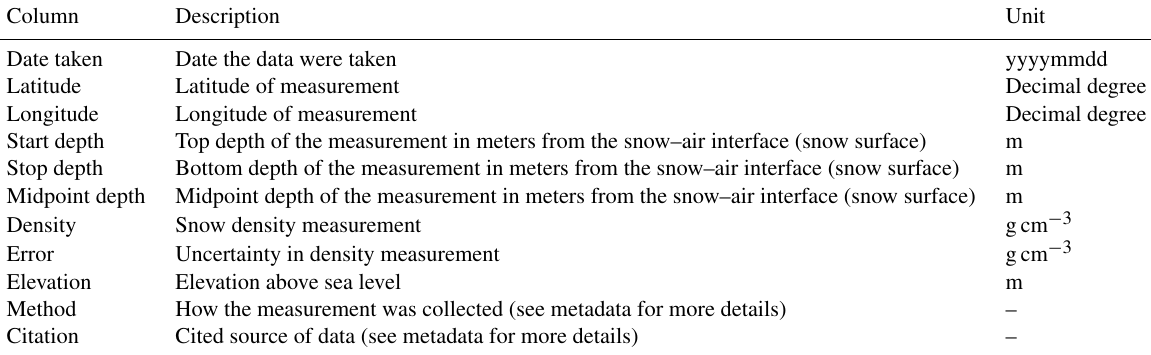
Table 1. The parameters for each snow density measurement in the SUMup dataset with a brief description and the unit of measurement. Column Description Unit Date taken Date the data were taken yyyymmdd Latitude Latitude of measurement Decimal degree Longitude Longitude of measurement Decimal degree Start depth Top depth of the measurement in meters from the snow–air interface (snow surface) m Stop depth Bottom depth of the measurement in meters from the snow–air interface (snow surface) m Midpoint depth Midpoint depth of the measurement in meters from the snow–air interface (snow surface) m Density Snow density measurement gcm − 3 Error Uncertainty in density measurement gcm − 3 Elevation Elevation above sea level m Method How the measurement was collected (see metadata for more details) –